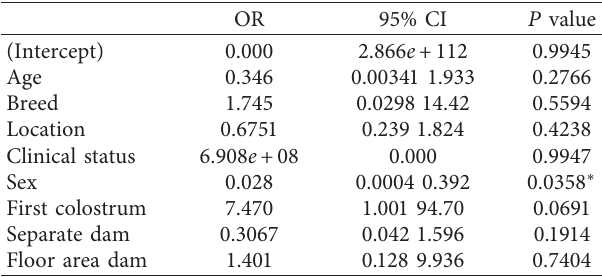
Table 3: Evaluation of the association between BRoV, diarrhoea, and other variables (age, breed, sex, location, clinical status, means of offering, and separation from